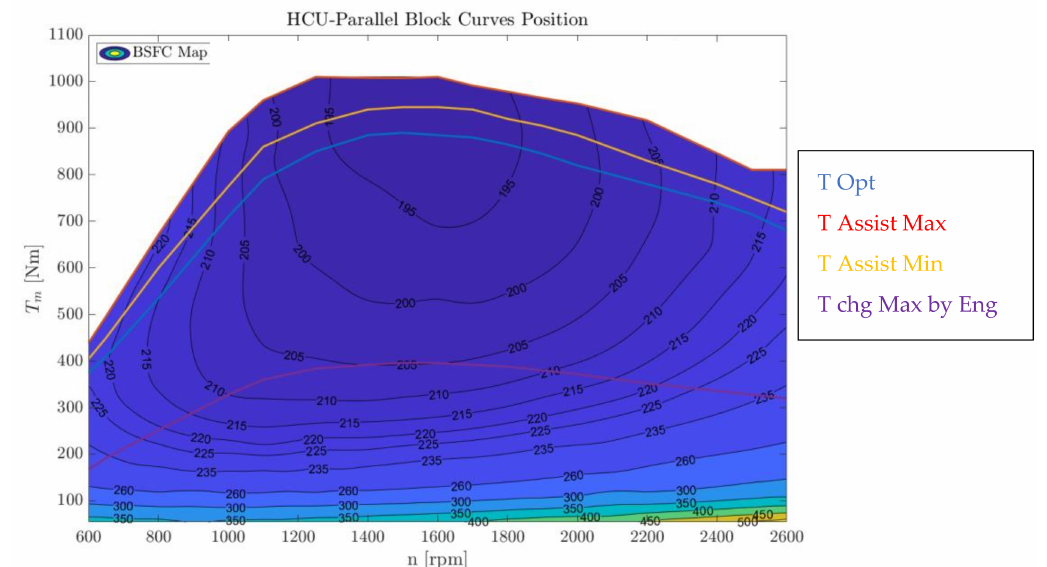
Figure 12. Position of the HCU-Parallel block curves on the engine BSFC map. The lowest purple line defines a map region below which the engine is generally prevented from working: when the requested engine torque lies below this curve, the HCU determines an increase of torque request, so as to bring the operating point above the purple line. Then, the torque surplus is used to charge the battery through the motor generator mode. This curve has been placed to achieve a compromise: it prevents the engine from working in low-efficiency points, such as the bottom part of the map, so that above this curve an optimal operation of the engine is achieved. The region between the purple line and the yellow one defines the area in which the engine can work. If the required torque is located between the yellow line and the red one the engine is supported by the electric motor to provide the requested